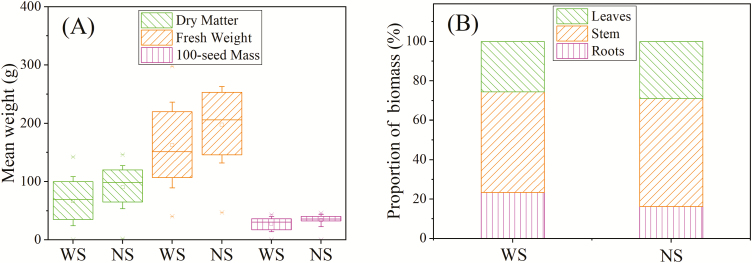
(A) Dry matter, fresh weight, and 100-seed mass per corncob (n=33; error bars represent ±1 SD); (B) mean proportions of biomass in the roots, stems, and leaves for the water stress (WS) and non-water stress (NS) treatments (n=3).